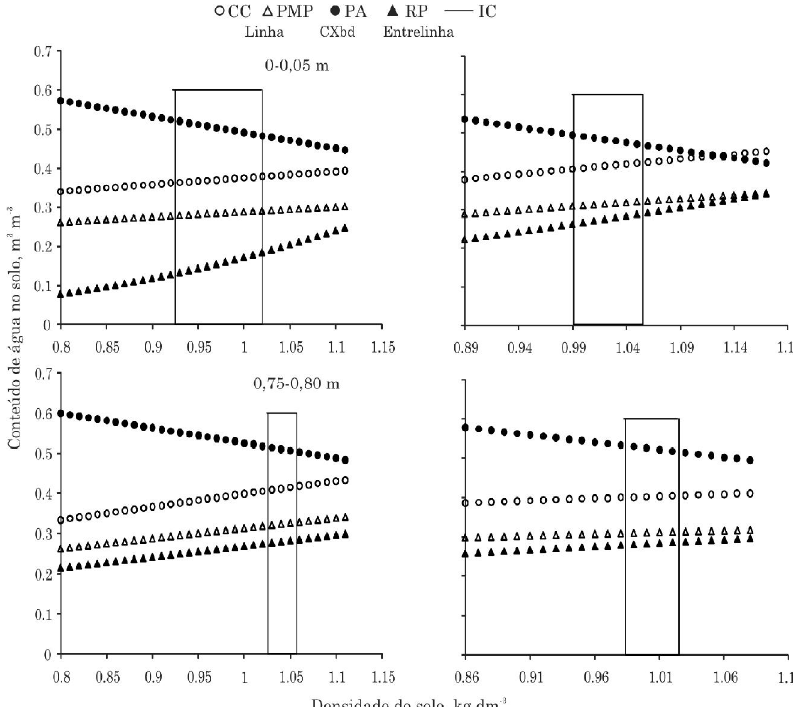
Figura 2. Variação do conteúdo de água ( (cid:84) ) com a densidade do solo para as situações de estudo do CXbd, nos níveis críticos de capacidade de campo ( (cid:84) CC ), ponto de murcha permanente ( (cid:84) PMP ), porosidade de aeração de 0,10 m 3 m -3 ( (cid:84) PA ) e resistência do solo à penetração de 3,0 MPa ( (cid:84) RP ). Área interna da coluna corresponde ao intervalo hídrico ótimo (IHO) presente nesses locais.